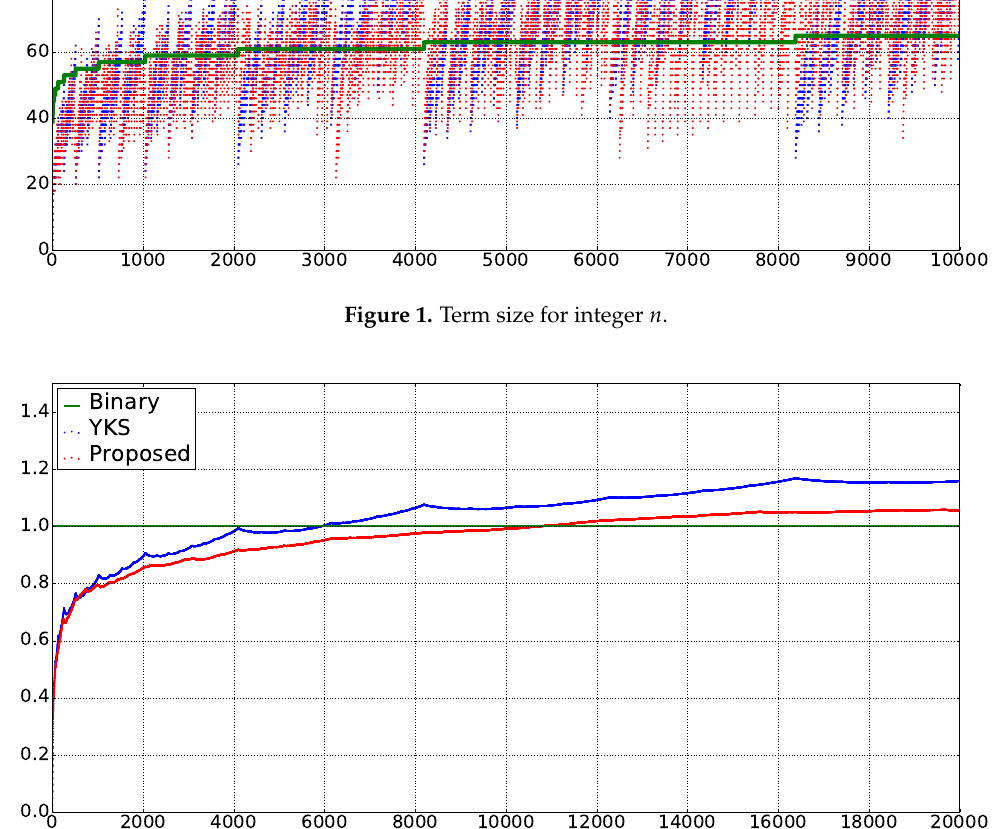
Figure 2. Average ratio to binary